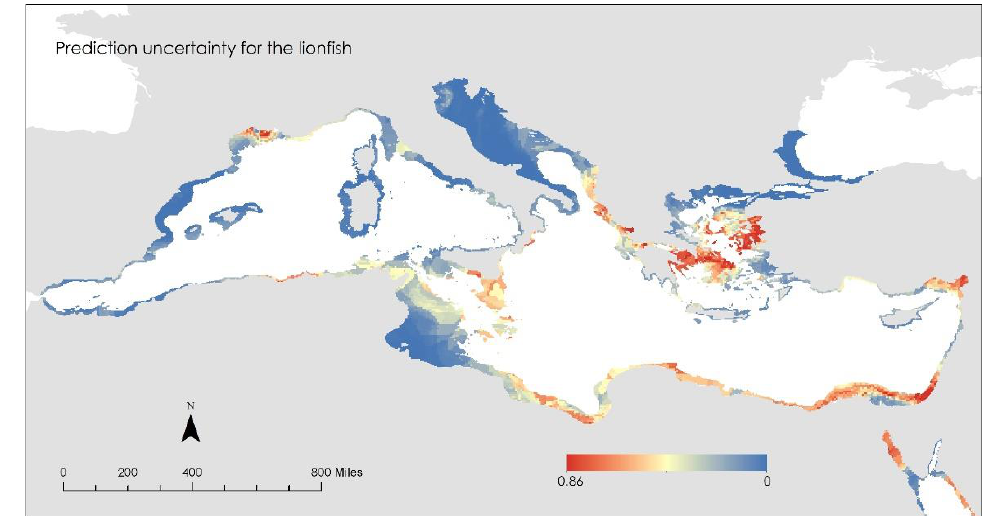
Figure 6. Lionfish prediction uncertainty.